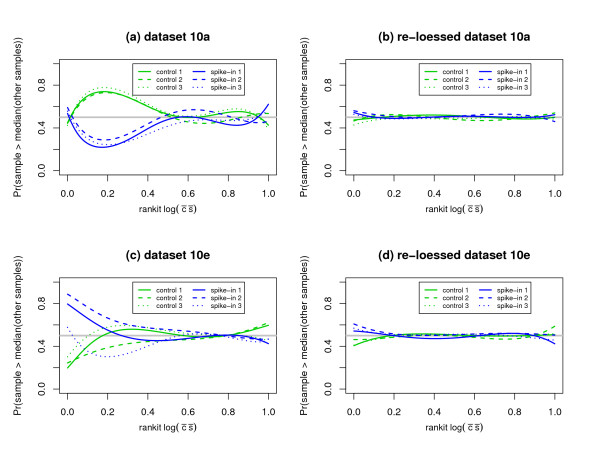
A diagnostic plot to assess, as a function of signal intensity, whether or not the underlying distributions for the expression values from each chip/sample share the same center. The x-axes correspond to the rankit (i.e., rank of valuetotal#of values+1
 MathType@MTEF@5@5@+=feaafiart1ev1aaatCvAUfKttLearuWrP9MDH5MBPbIqV92AaeXatLxBI9gBaebbnrfifHhDYfgasaacH8akY=wiFfYdH8Gipec8Eeeu0xXdbba9frFj0=OqFfea0dXdd9vqai=hGuQ8kuc9pgc9s8qqaq=dirpe0xb9q8qiLsFr0=vr0=vr0dc8meaabaqaciaacaGaaeqabaqabeGadaaakeaadaWcaaqaaiabbkhaYjabbggaHjabb6gaUjabbUgaRjabbccaGiabb+gaVjabbAgaMjabbccaGiabbAha2jabbggaHjabbYgaSjabbwha1jabbwgaLbqaaiabbsha0jabb+gaVjabbsha0jabbggaHjabbYgaSjabcocaJiabb+gaVjabbAgaMjabbccaGiabbAha2jabbggaHjabbYgaSjabbwha1jabbwgaLjabbohaZjabgUcaRiabigdaXaaaaaa@52A7@) of the log of the product of the expression means. The y-axes correspond the probability that the observed expression value for a given sample will exceed the median of the expression values for the samples not under direct examination. The horizontal solid gray line corresponds to a probability of rank of valuetotal#of values+1
 MathType@MTEF@5@5@+=feaafiart1ev1aaatCvAUfKttLearuWrP9MDH5MBPbIqV92AaeXatLxBI9gBaebbnrfifHhDYfgasaacH8akY=wiFfYdH8Gipec8Eeeu0xXdbba9frFj0=OqFfea0dXdd9vqai=hGuQ8kuc9pgc9s8qqaq=dirpe0xb9q8qiLsFr0=vr0=vr0dc8meaabaqaciaacaGaaeqabaqabeGadaaakeaadaWcaaqaaiabbkhaYjabbggaHjabb6gaUjabbUgaRjabbccaGiabb+gaVjabbAgaMjabbccaGiabbAha2jabbggaHjabbYgaSjabbwha1jabbwgaLbqaaiabbsha0jabb+gaVjabbsha0jabbggaHjabbYgaSjabcocaJiabb+gaVjabbAgaMjabbccaGiabbAha2jabbggaHjabbYgaSjabbwha1jabbwgaLjabbohaZjabgUcaRiabigdaXaaaaaa@52A7@. The probability that the sample under consideration will have an expression value greater than the median of the expression values for the samples not under direct examination, was modeled as the logit of a 4th order polynomial for rankit intensity. Colored lines correspond to the logistic regression fit values. The within subpopulation logistic model fits are remarkably consistent for dataset 10a and are less so for dataset 10e. Plots (a) and (b) suggest that problems with relative centering can not be attributed to one or two "outlying" samples. Rather, these plots support the hypothesis that the Stage I pre-processing algorithms could not adequately adjust for differences in the underlying population distributions of the expression values for the empty probesets.